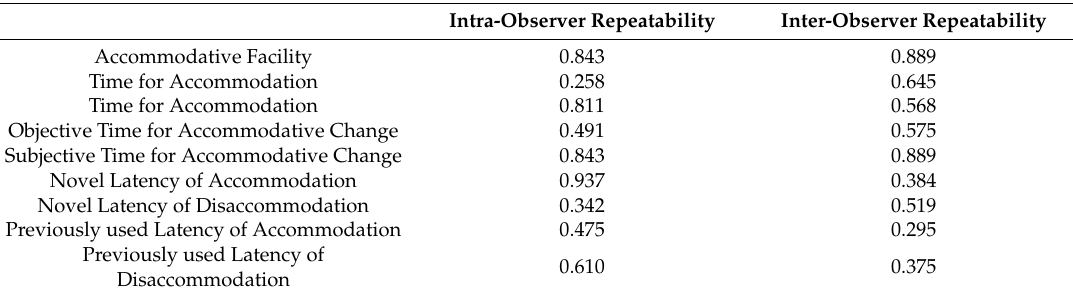
Table 3. The Intraclass correlation coefficients of each measured metric, showing both intra-observer repeatability and inter-repeatability.